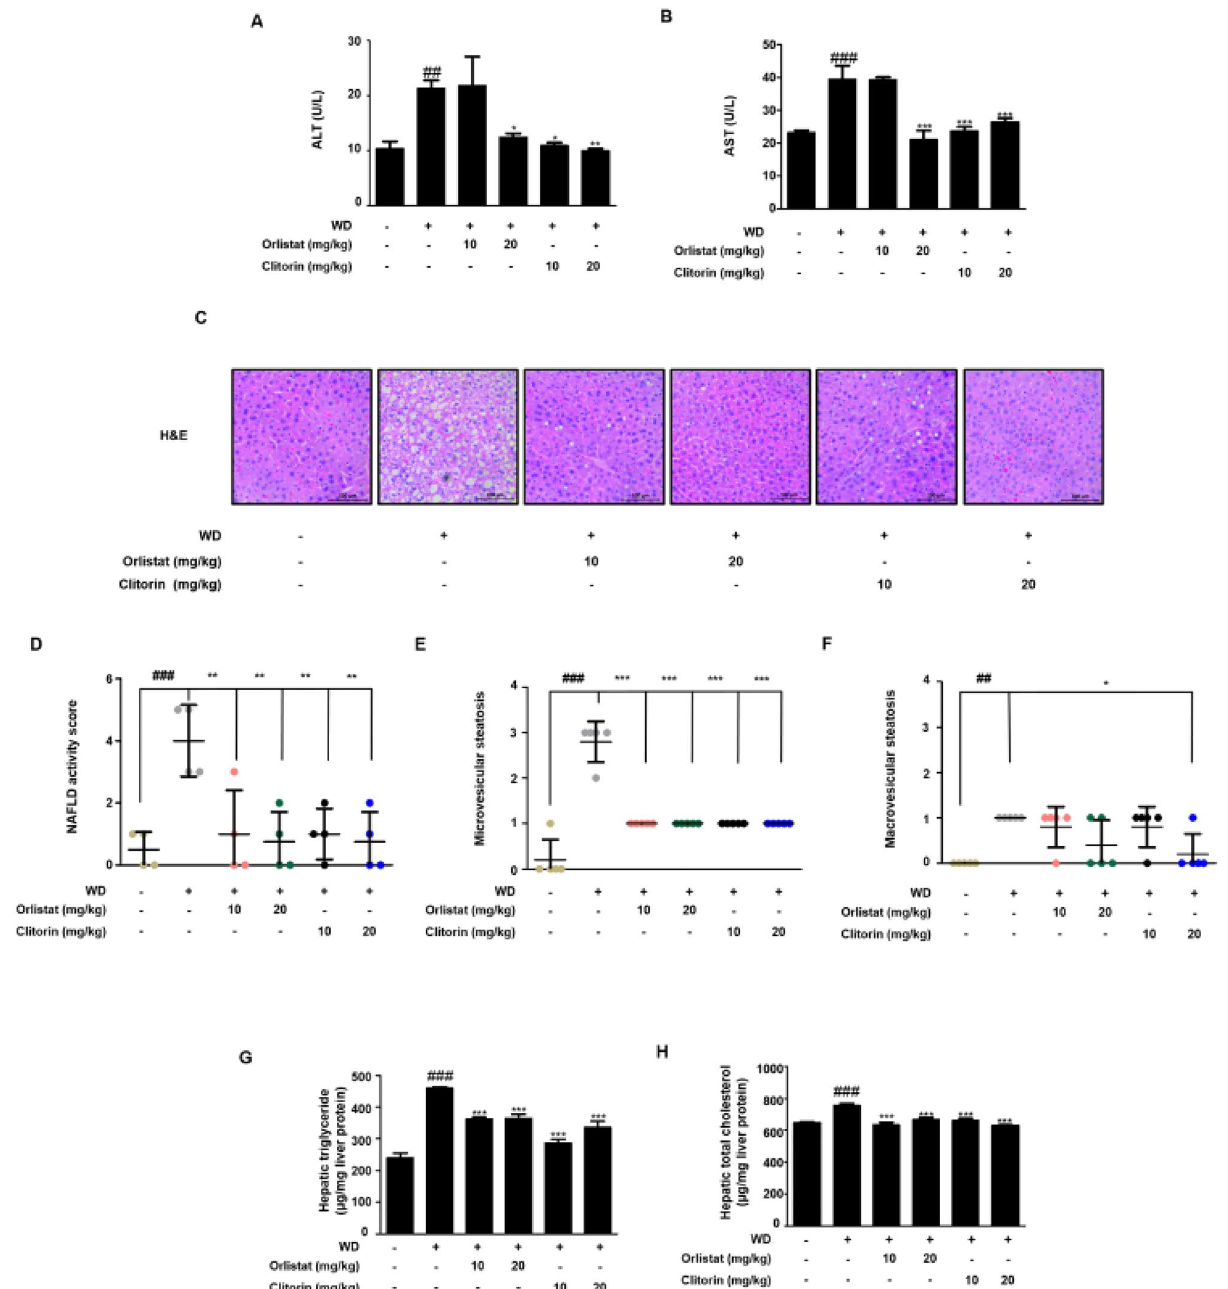
Figure 3. Effect of clitorin on the hepatic steatosis in the WD-induced hepatic steatosis mouse model. The levels of serum ( A ) ALT and ( B ) AST were determined using enzymatic methods. ( C ) The liver tissues from representative mice in each group were fixed, embedded in paraffin, and stained with H&E solution. Images are shown at an original magnification of 200 × . The scale bar is 100 µm. ( D ) NAS, ( E ) micro-, and ( F ) macro-vesicular steatosis were determined. The levels of hepatic ( G ) triglyceride and ( H ) total cholesterol were determined using enzymatic methods. The values are represented as the mean ± SD (n = 6 per group). ## P < 0.01 and ### P < 0.001 vs. CON group; *P < 0.05, **P < 0.01, and ***P < 0.001 vs. WD group; significance was determined using one-way ANOVA followed by Dunnett’s post hoc test. WD western diet, ALT alanine aminotransferase, AST aspartate aminotransferase, H&E hematoxylin and